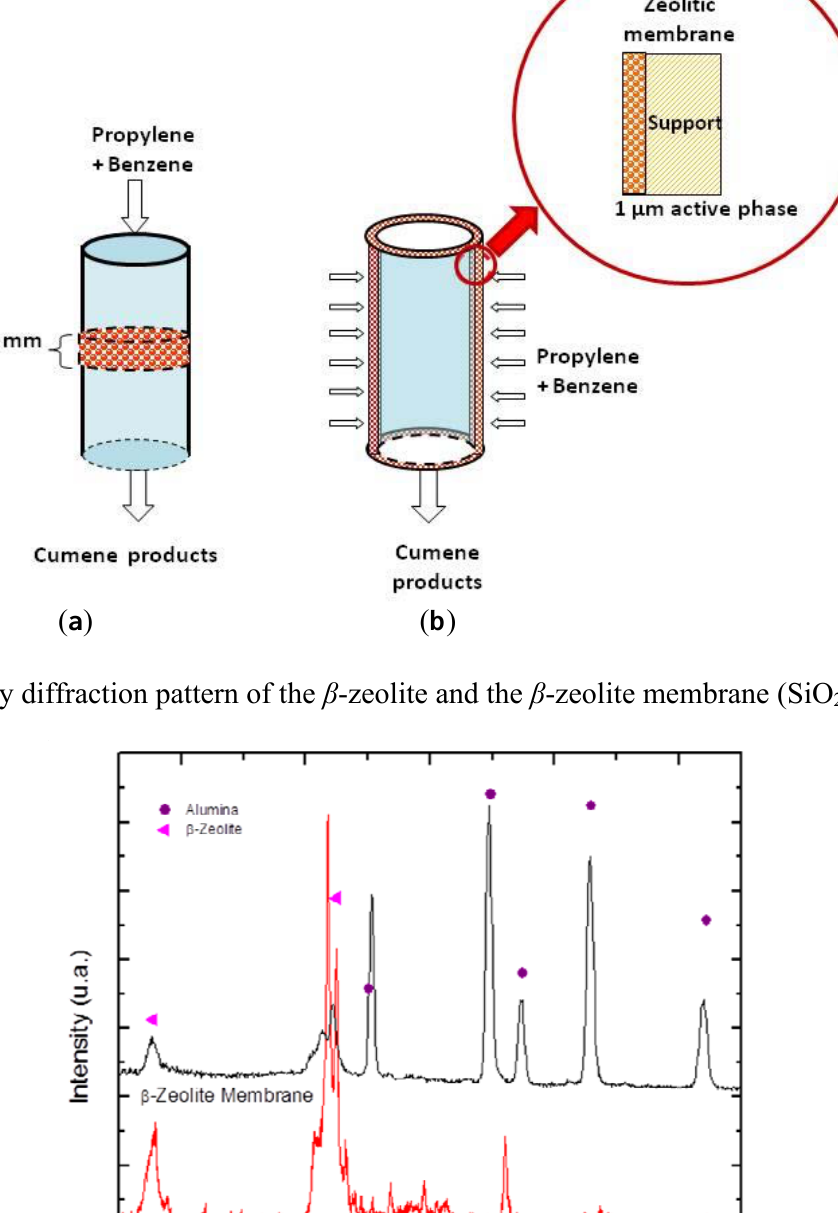
Figure 1. Schematic diagram of ( a ) the fixed-bed reactor and ( b ) the flow-through membrane reactor.